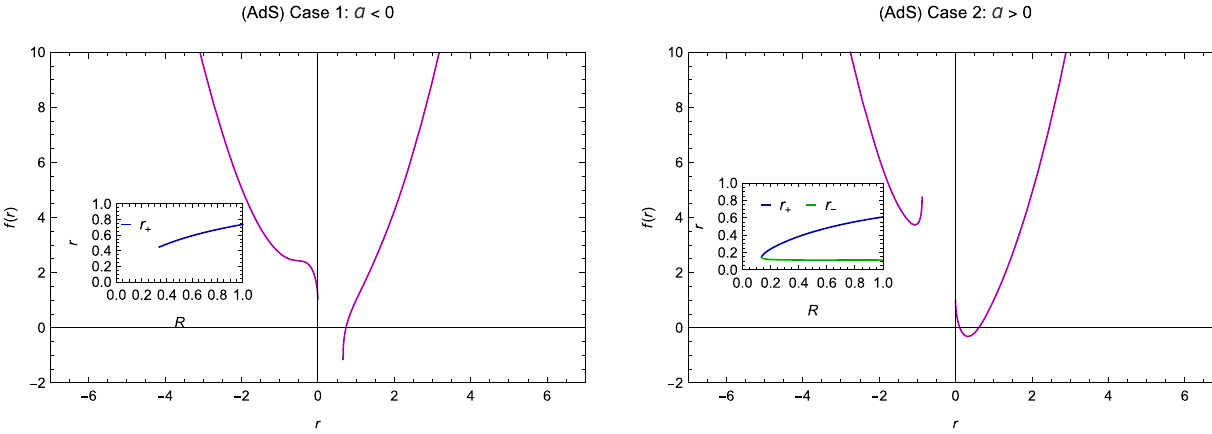
Fig. 8 The metric function f ( r ) for a = − 0 . 20 (left) and a = 0 . 20 (right); M = 1 /